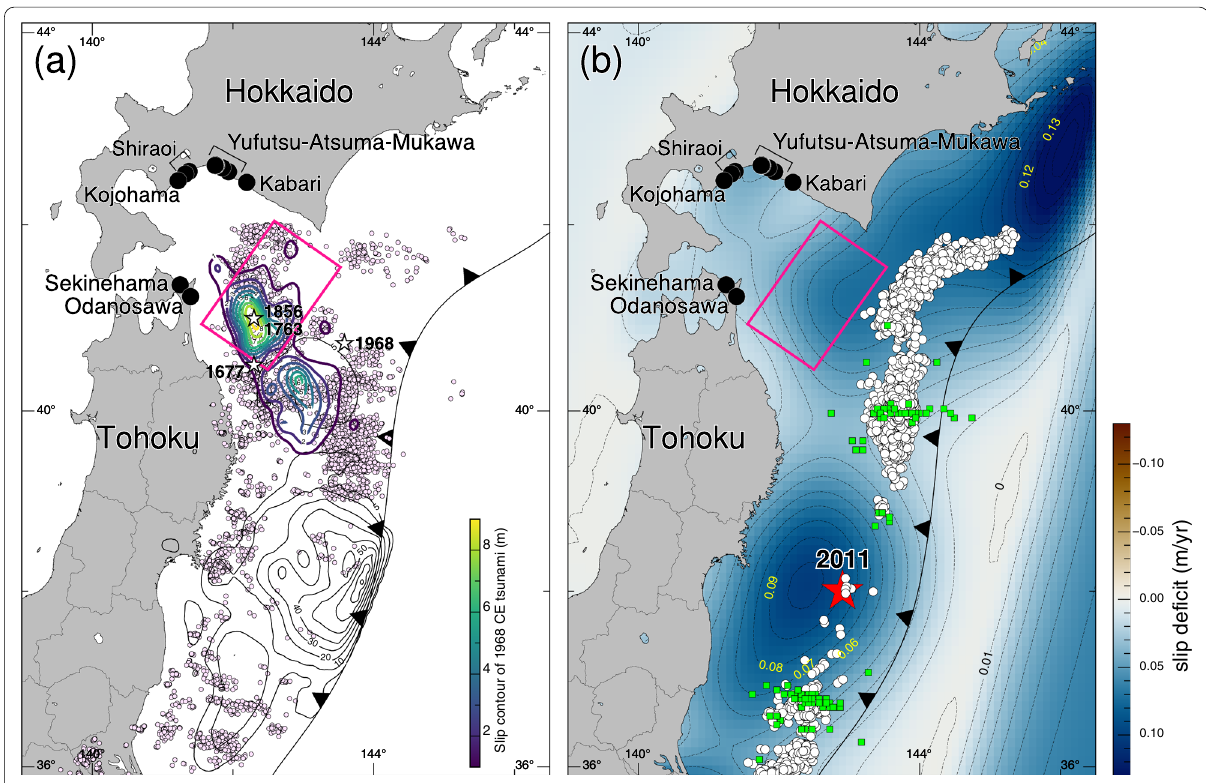
Fig. 10 Seismological characteristics in Hokkaido and Tohoku regions. a The interplate earthquakes occurring from 1984 to 2013 CE compiled by Nakamura et al. (2016), b the distribution of slip deficit, compiled by Suwa et al. (2006), and slow earthquake distributions, compiled by Nishikawa et al. (2019). The black and viridis-color lines in a represent contour with a 10 m slip interval of the 2011 Tohoku-oki tsunami by Iinuma et al. (2012) and with a 1 m slip interval of the 1968 CE Tokachi-oki tsunami by Nagai et al. (2001), respectively. The slip deficit is estimated from three-dimensional global positioning system velocity data from 1997 to 2001 CE by Suwa et al. (2006). The white stars indicate the epicenters of historical earthquake (see Table 1 for detail). The viridis-color bar in a shows the slip amount; yellow is large, and purple is small. The white circles in b show the epicenters of tectonic tremor occurrence from August 2016 to August 2018. The light green circles in b denote the epicenters of very-low-frequency earthquakes from January 2005 to August 2018 CE. These data refer directly to the original supplement data in Nishikawa et al. (2019). The red star in b shows the main shock epicenter of the 2011 CE earthquake. The black circles in a and b indicate the explainable sites by the S2 model. The dark pink frame in a and b shows the rupture area of the S2